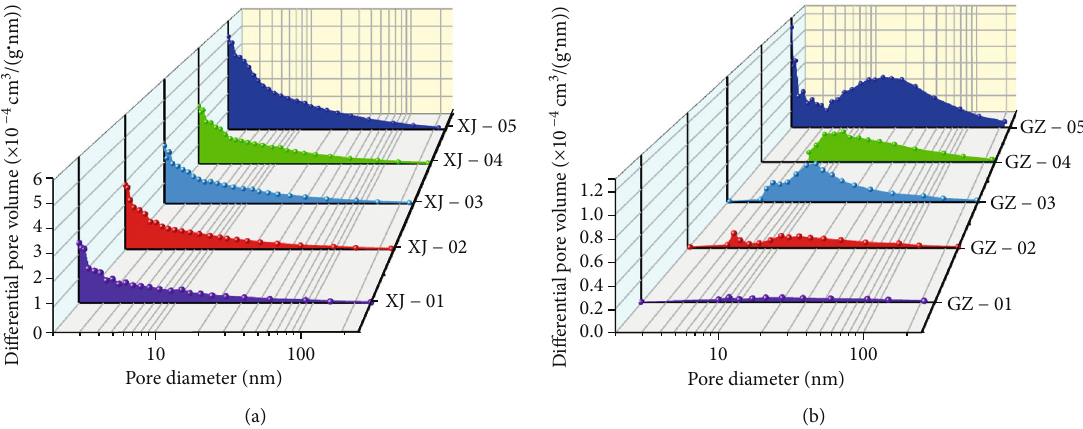
adsorption analysis. (a) Coal XJ 2